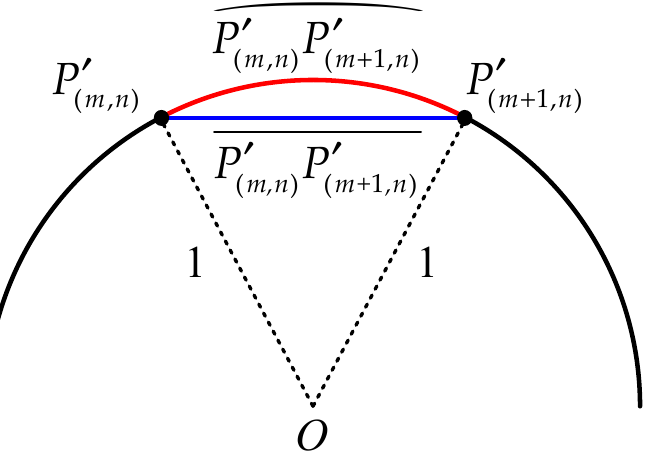
P (cid:48) and P (cid:48) , as demonstrated in Figure 7. Note that the length is the sampling ( m , n ) ( m + 1, n ) interval that is used to generate a VP from a 360 ◦ image.